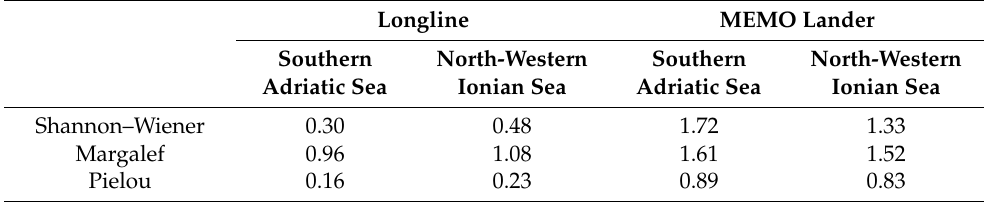
Table 3. Ecological indices computed in the southern Adriatic Sea and north-western Ionian Sea using longline and baited lander.